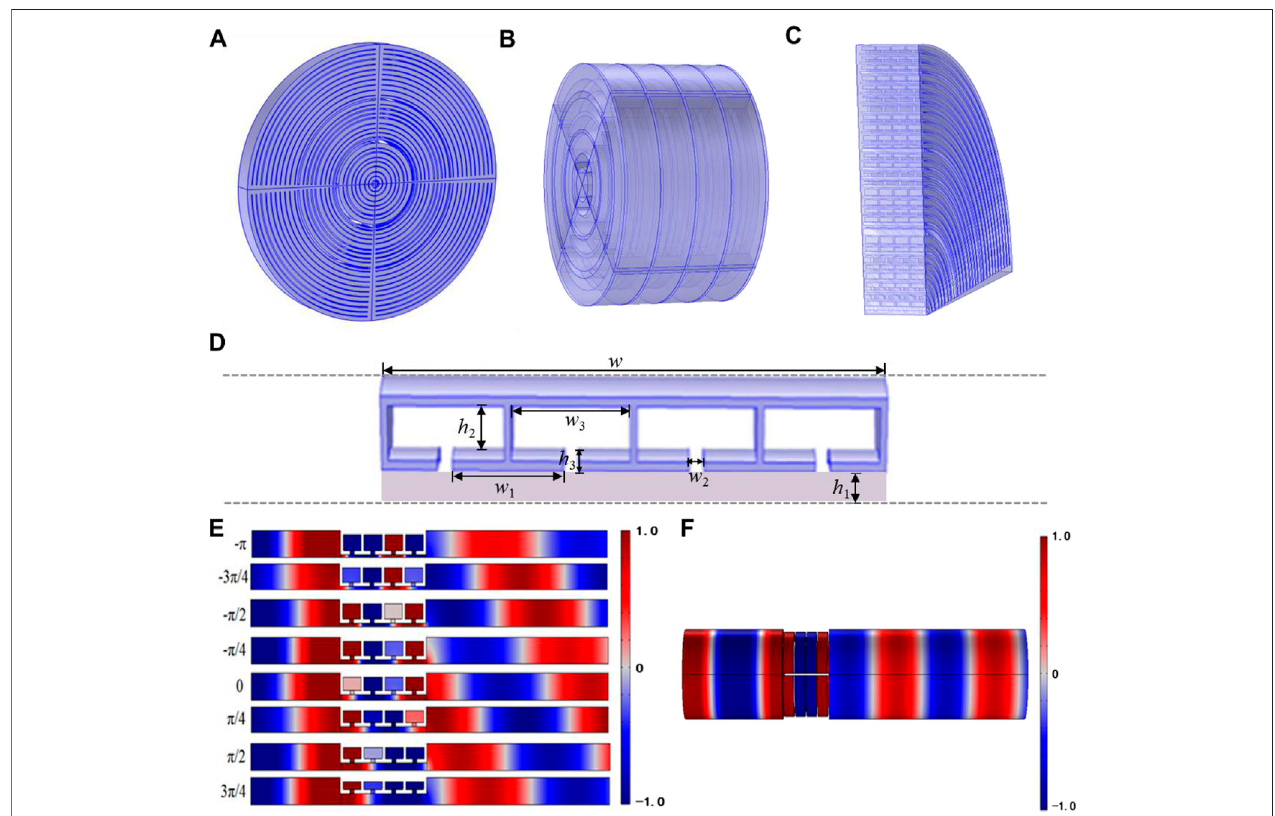
FIGURE 1 | Two-dimensional acoustic meta-lens design. (A) Overall sample diagram with a schematic representation of the assembled layer consisting of four fanlike sections of resonators. (B) Schematic representation of a section of the three-dimensional structure. (C) Quarter of the acoustic meta-lens. (D) Hybrid structure consisting of a straight pipe and four Helmholtz resonators (HRs). (E) Simulations of the transmission through eight elements result in an equally increased phase shift with a step of π /4. (F) Transmittance of the simulated third layer unit is 0.84.